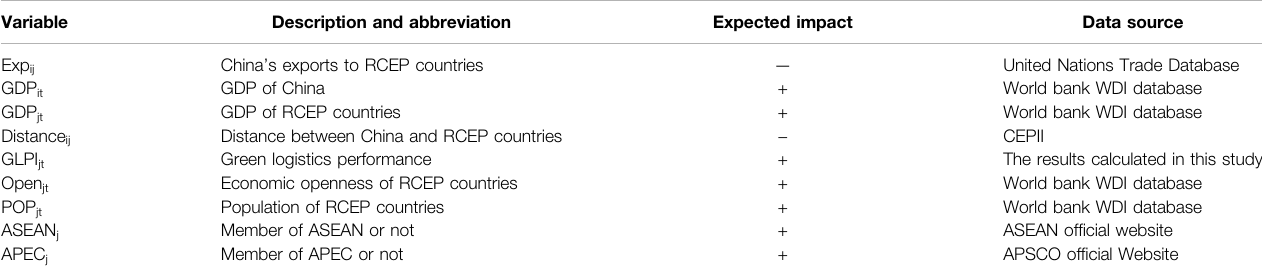
TABLE 4 | De fi nition of variables and data sources. Variable